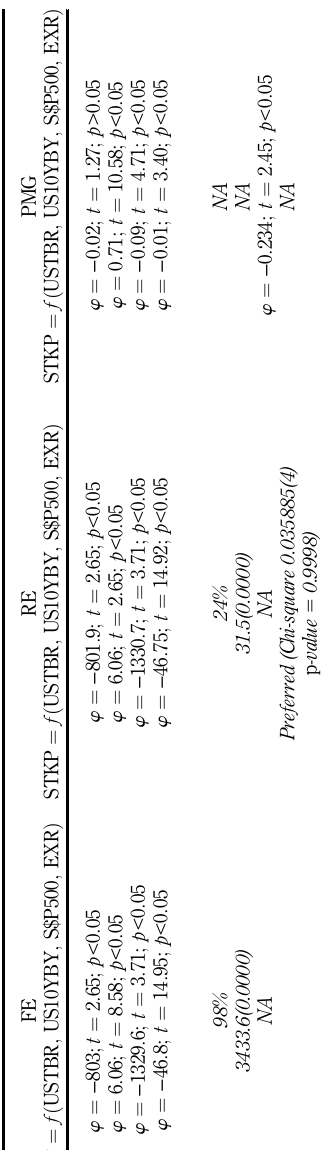
Table 4. Summary of panel